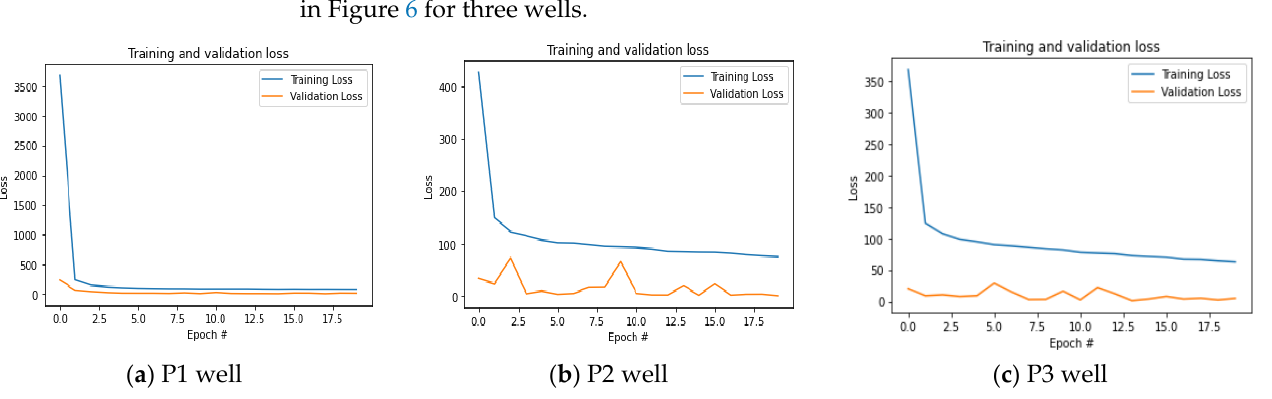
Figure 6. Loss vs. Epoch on validation data during training for different wells.